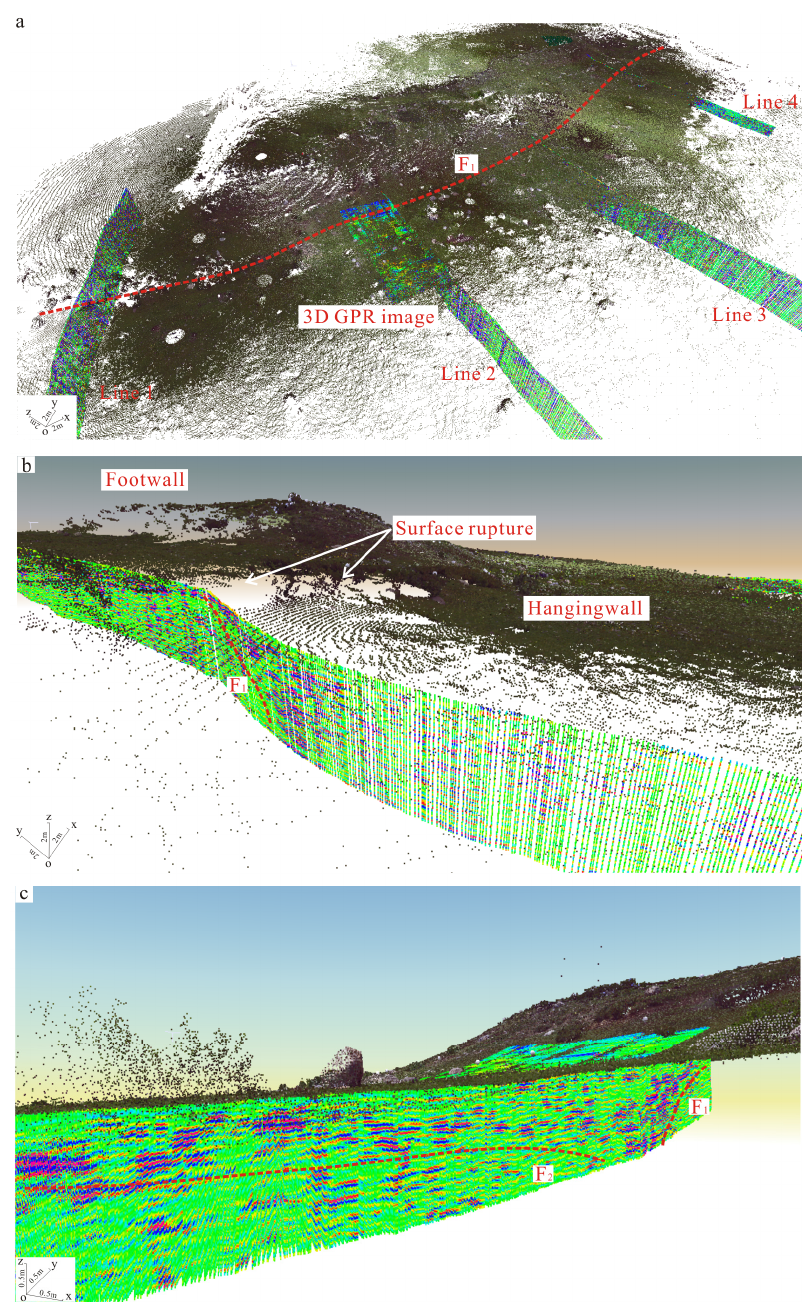
Figure 12. Data visualization of point clouds and GPR profiles. ( a,b ) show data visualization of point clouds and 2D and 3D GPR profiles. ( c ) show data visualization of point clouds and 3D GPR profiles.